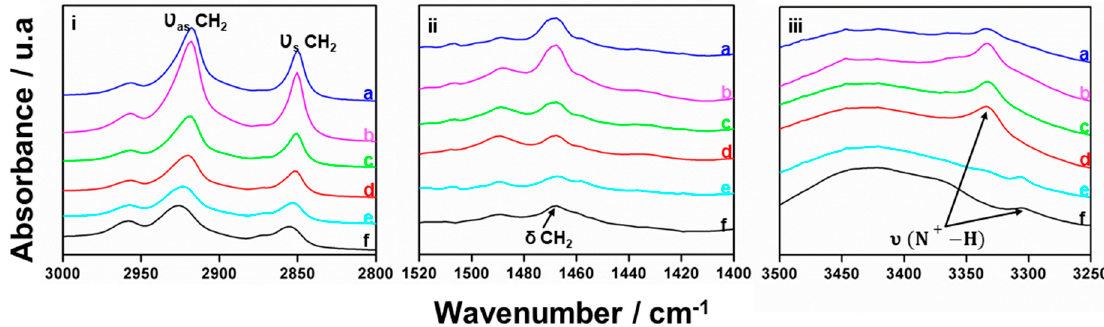
Figure 3. FTIR spectra of samples ( a ) UVM-L18, ( b ) UVM-L16, ( c ) UVM-L14, ( d ) UVM-L12, ( e ) UVM-L10, and ( f ) UVM-L8. ( i ) Stretching C–H modes. ( ii ) Bending H–C–H modes. ( iii ) Stretching N–H bonds.